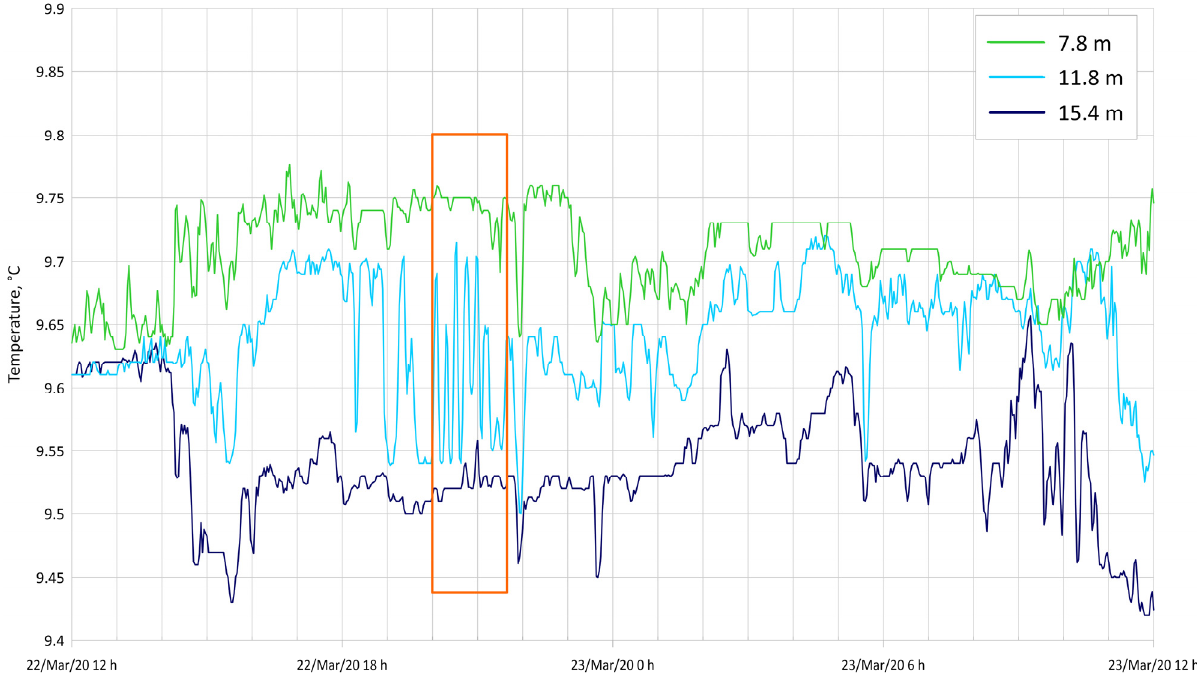
Figure 15. Water temperature at 7.8 m (green line), on 11.8 m (blue line) depths and on horizon at 15.6 m (dark blue line) from 22 March to 23 March 2020. Period of the ~13 min internal waves is marked by the red rectangle.